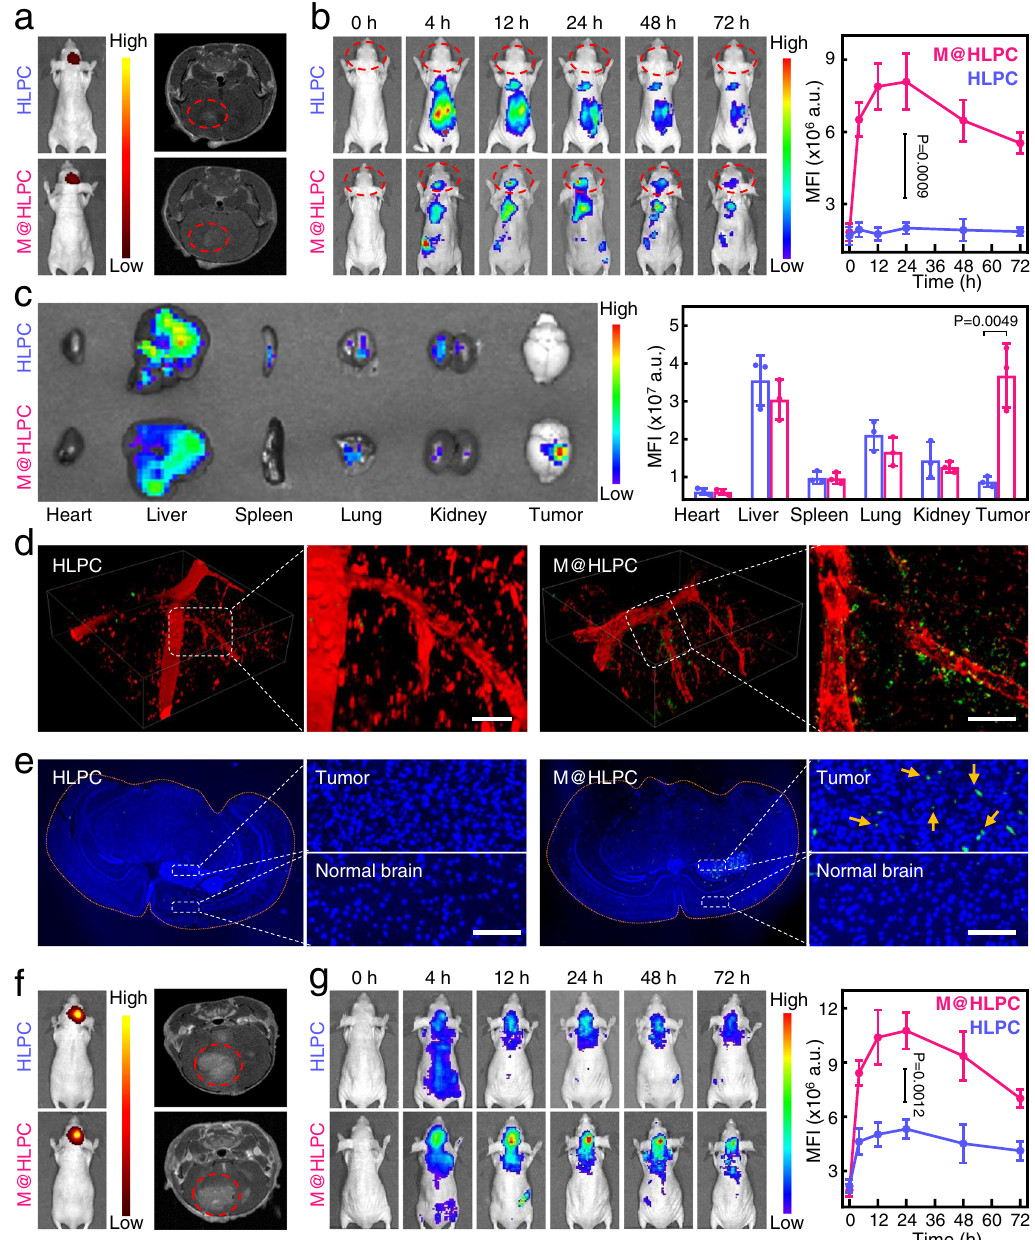
Fig. 5 In vivo evaluation for the glioma-targeting of M@HLPC in orthotopic U251-luc glioma-bearing mice. a Representative bioluminescence images and MRI transverse section view of small-size glioma-bearing mice at 9 days ’ post tumor cell inoculation. The mice were randomly divided into two groups and i.v. injected with HLPC or M@HLPC for the subsequent distribution analysis. Red circles: tumor regions. b In vivo distributions and the signal pro fi les of HLPC or M@HLPC in small-size U251-luc glioma-bearing Balb/c nude mice at different time points post i.v. injection. The fl uorescence signals originate from Ce6 inside the formed NPs. c Representative ex vivo fl uorescence images and corresponding quantitative fl uorescence analysis of major organs and glioma tumors dissected from glioma-bearing mice at 24h after i.v. injection with HLPC or M@HLPC. d In vivo two-photon images indicating the diffusion of HLPC and M@HLPC across the brain microvascular endothelial cells. Red: Tetramethylrhodamine isothiocyanate dextran-labeled blood vessels; green: NPs. Scale bar: 50 μ m. e Representative fl uorescence images of frozen brain sections at 24h post NPs injection showed the effective accumulation of M@HLPC as yellow arrows indicated in the enlargement. Blue: Hoechst 33342-labeled nuclei; green: NPs. Scale bar: 50 μ m. f Representative bioluminescence images and MRI transverse section view of large glioma-bearing mice at 18 days ’ post U251 tumor cell inoculation. The mice were randomly divided into two groups and i.v. injected with HLPC or M@HLPC for the subsequent analysis of distributions. Red circles: tumor regions. g In vivo distributions and the signal pro fi les of HLPC or M@HLPC in large-size U251-luc glioma-bearing Balb/c nude mice at different time points post i.v. injection. The fl uorescence signals originate